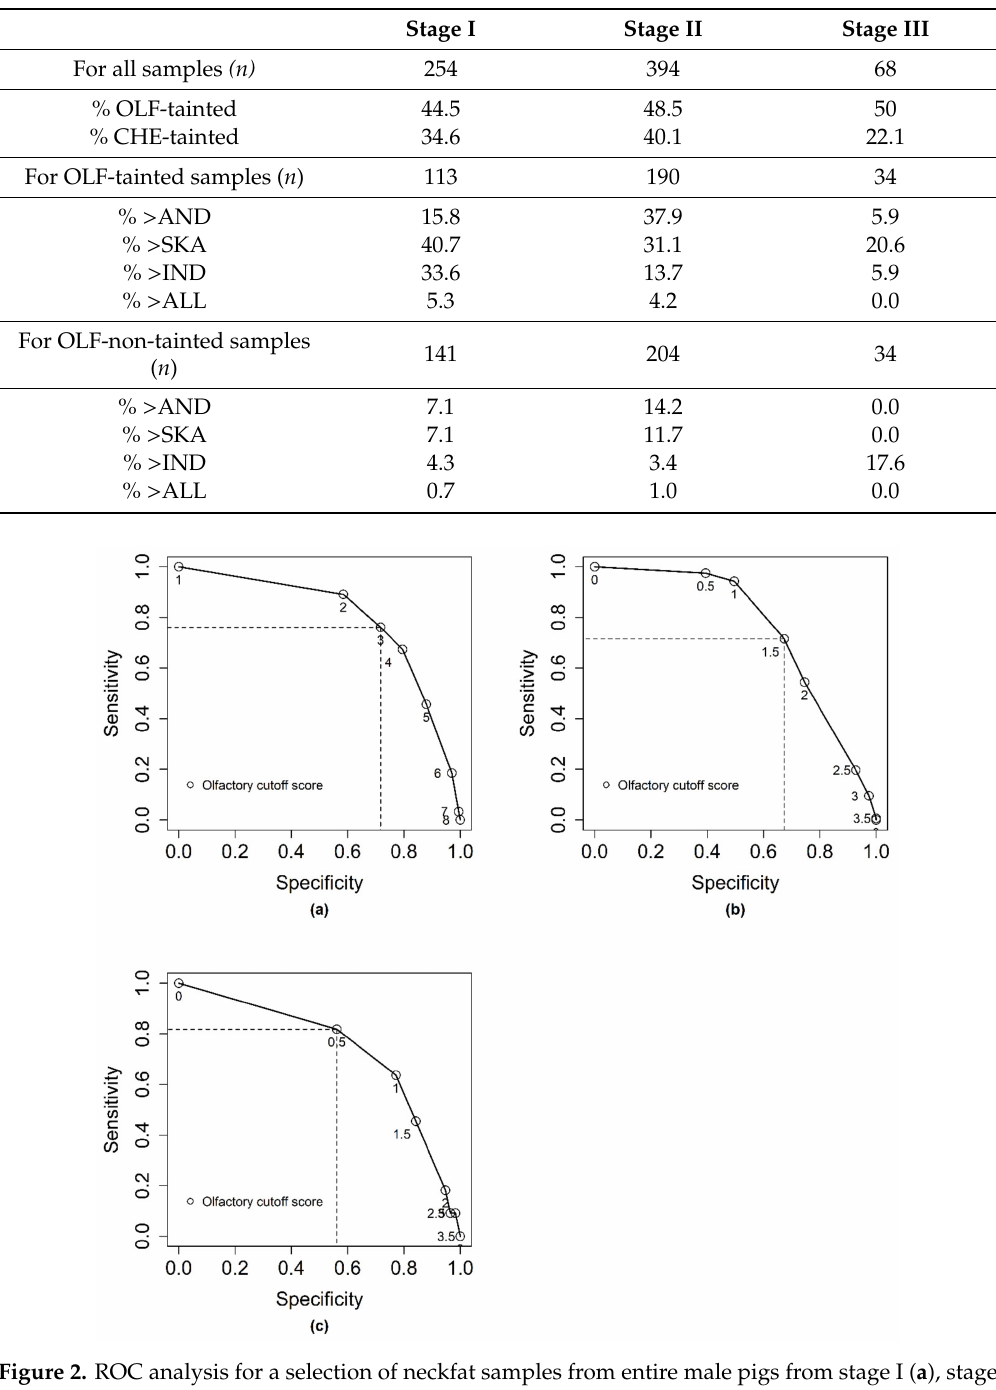
Figure 2. ROC analysis for a selection of neckfat samples from entire male pigs from stage I ( a ), stage II ( b ), and stage III ( c ) of olfactory detection method optimization. Sensitivity and specificity are shown for each possible olfactory cuto ff score compared to exceeding the cuto ff levels for androstenone (cuto ff = 2.0 µ g / g), skatole (cuto ff = 0.25 µ g / g), and indole (cuto ff = 0.15 µ g /